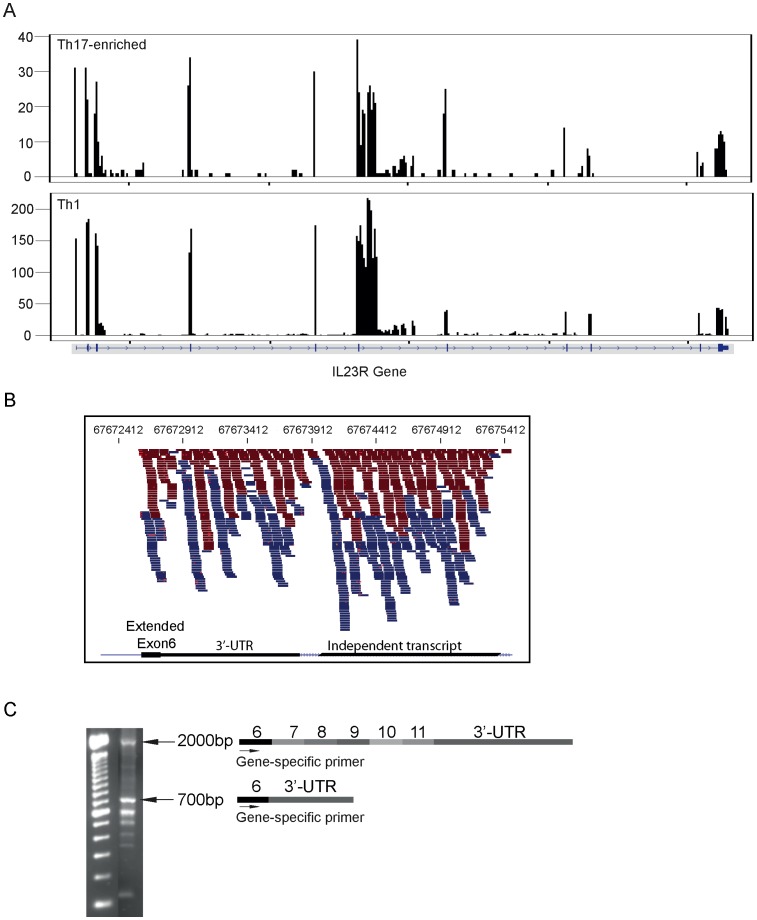
Abundantly expressed, novel IL23R isoform.A. Sequence reads were mapped to the IL23R gene region in Th17-enriched and in vitro differentiated Th1 cells using Tophat v1.3.3. The intron 6 region was highly covered in both the Th17-enriched and Th1 cell subsets. The scale on the y-axis represents coverage (average number of reads that cover a particular base). B. Zoom in picture of extended coverage on exon 6 and intron 6. Blue and red bars correspond to sense- and anti-sense reads, respectively. The expanded inset demonstrates sequence reads mapping to an extended exon 6 resulting in a stop signal 9 codons downstream with contiguous 3′UTR sequence; in addition an independent transcript maps immediately centromeric to this. C. 3′ RACE (rapid amplification of cDNA ends) was performed, and 2000 and 700 base pair fragments were sequenced, confirming the exon contents designated. The 700 base pair transcript terminating in the intron 6 region would encode for a transcript terminating prior to the transmembrane domain in exon 9.